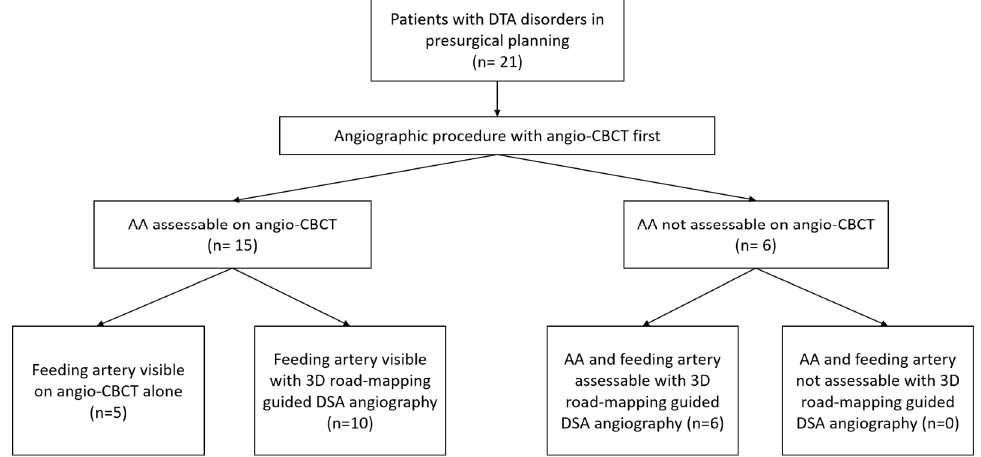
Figure 4. Study flow chart. DTA: descending thoracic aorta; AA: Adamkiewicz artery. The median and interquartile irradiation dose was 25.5 (20.0–40.0) Gy/cm 2 for the positive angio-CBCT group and 70.4 (30.8–96.9) Gy/cm 2 for the negative angio-CBCT